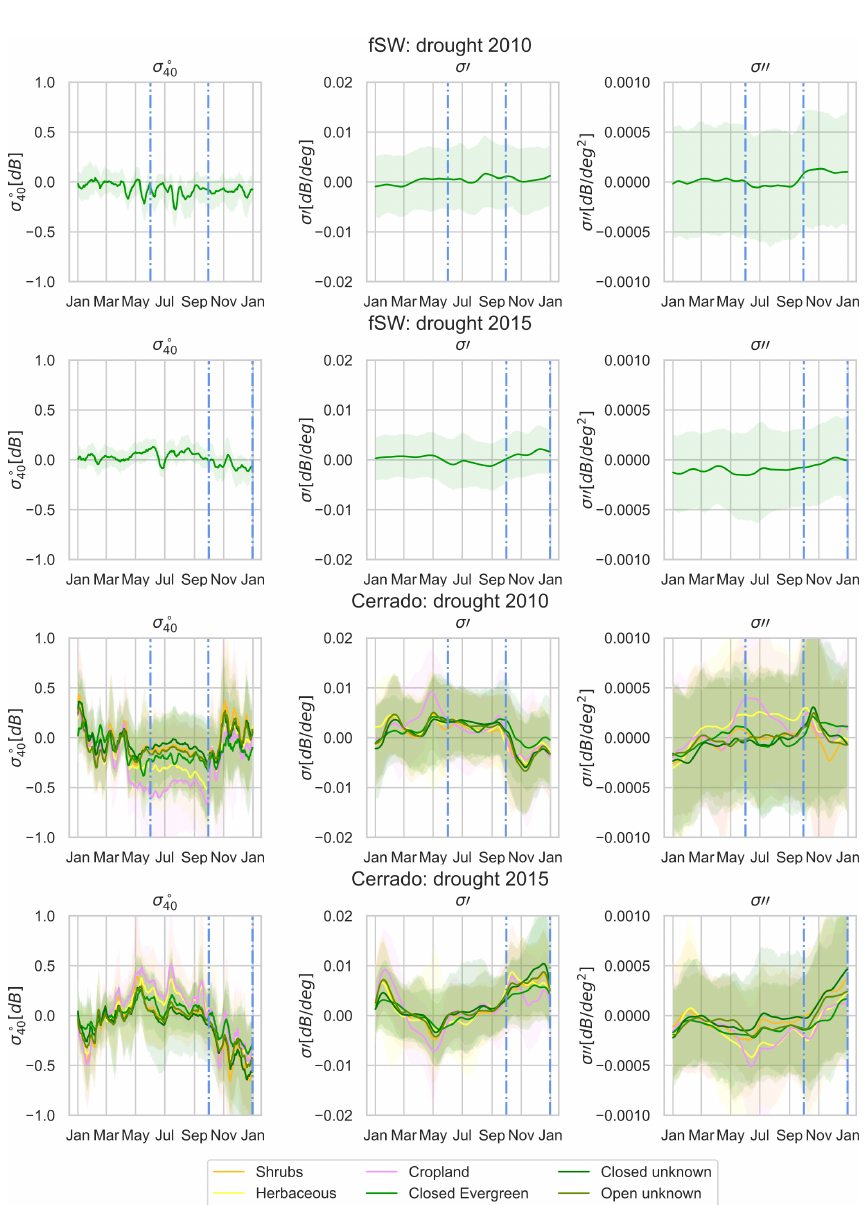
Figure 15. Time series of anomalies in backscatter, slope, and curvature for moist forest (fsW) and Cerrado region. The shaded areas indicate the 5th and 95th percentile. The peak drought intervals (June–September 2010 and September–December 2015) are shown within dash–dotted blue